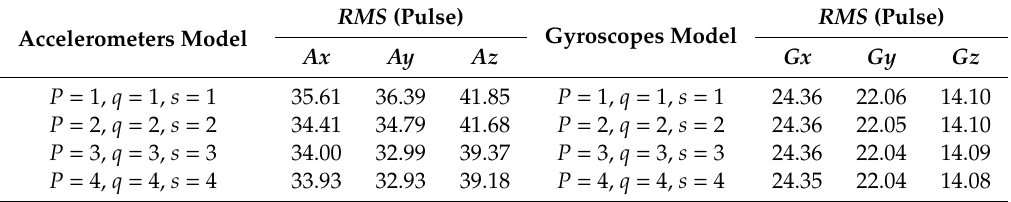
Table 5. The relationship between the model in method 2 and the RMS of calibration